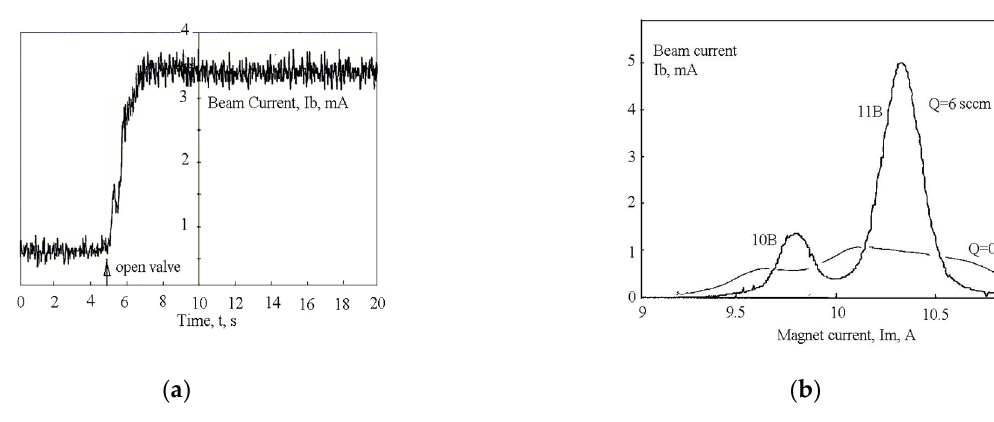
Figure 6. ( a ) Oscillogram showing the increase of beam intensity after the analyzer following injection of electronegative gas; the beam was of 11 B + ions with energy 3 keV and BF 3 neutralizing gas with flux up to 4.6 sccm was injected. ( b ) Mass spectrum of 3 keV B + beam after analyzer magnet for different neutralizing electronegative gas fluxes.